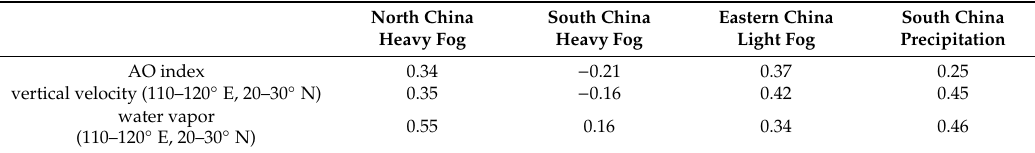
Table 2. Correlation coefficient of fog days in different regions with the AO index and regional meteorological fields (above 0.22 or 0.27 represents the values above the 90% or 95% confidence level, respectively).